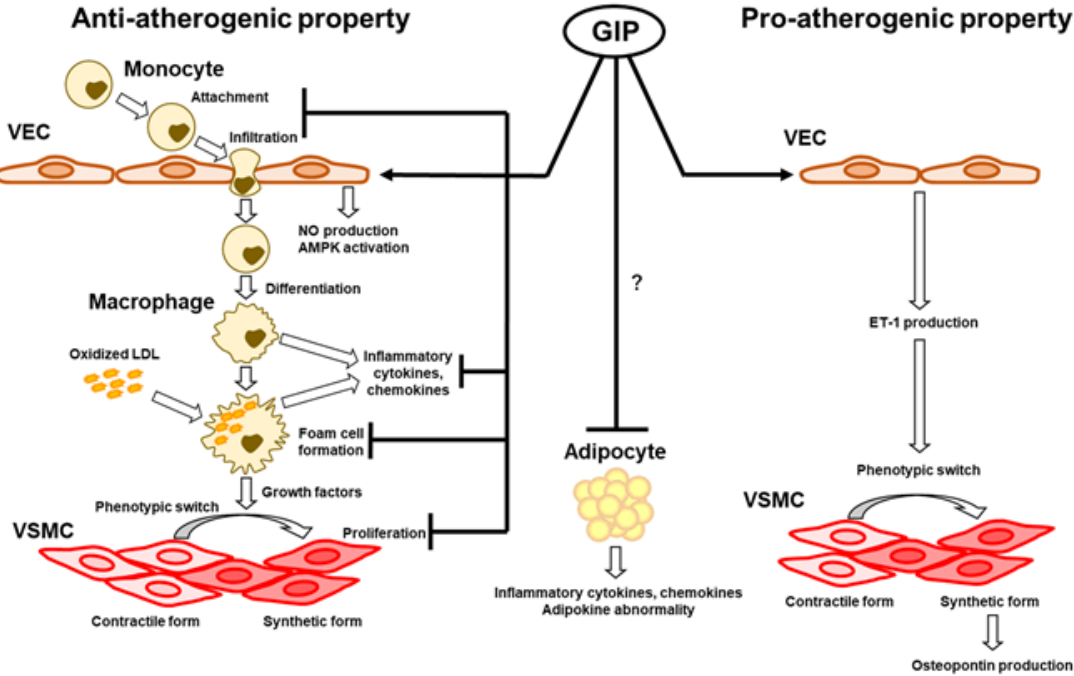
Figure 1. Anti-atherogenic and proatherogenic properties of GIP in vasculatures. Anti-atherogenic e ff ects of GIP are induced by enhancement of nitric oxide (NO) production and AMP-activated protein kinase (AMPK) activation in vascular endothelial cells (VECs), suppression of cell proliferation in vascular smooth muscle cells (VSMCs), and suppression of inflammatory responses and form cell formation in monocytes / macrophages or adipocytes. Pro-atherogenic e ff ects of GIP are associated with enhancement of endothelin-1 (ET-1) production in VECs, ET-1-mediated osteopontin production in VSMCs, and provocation of inflammatory responses in